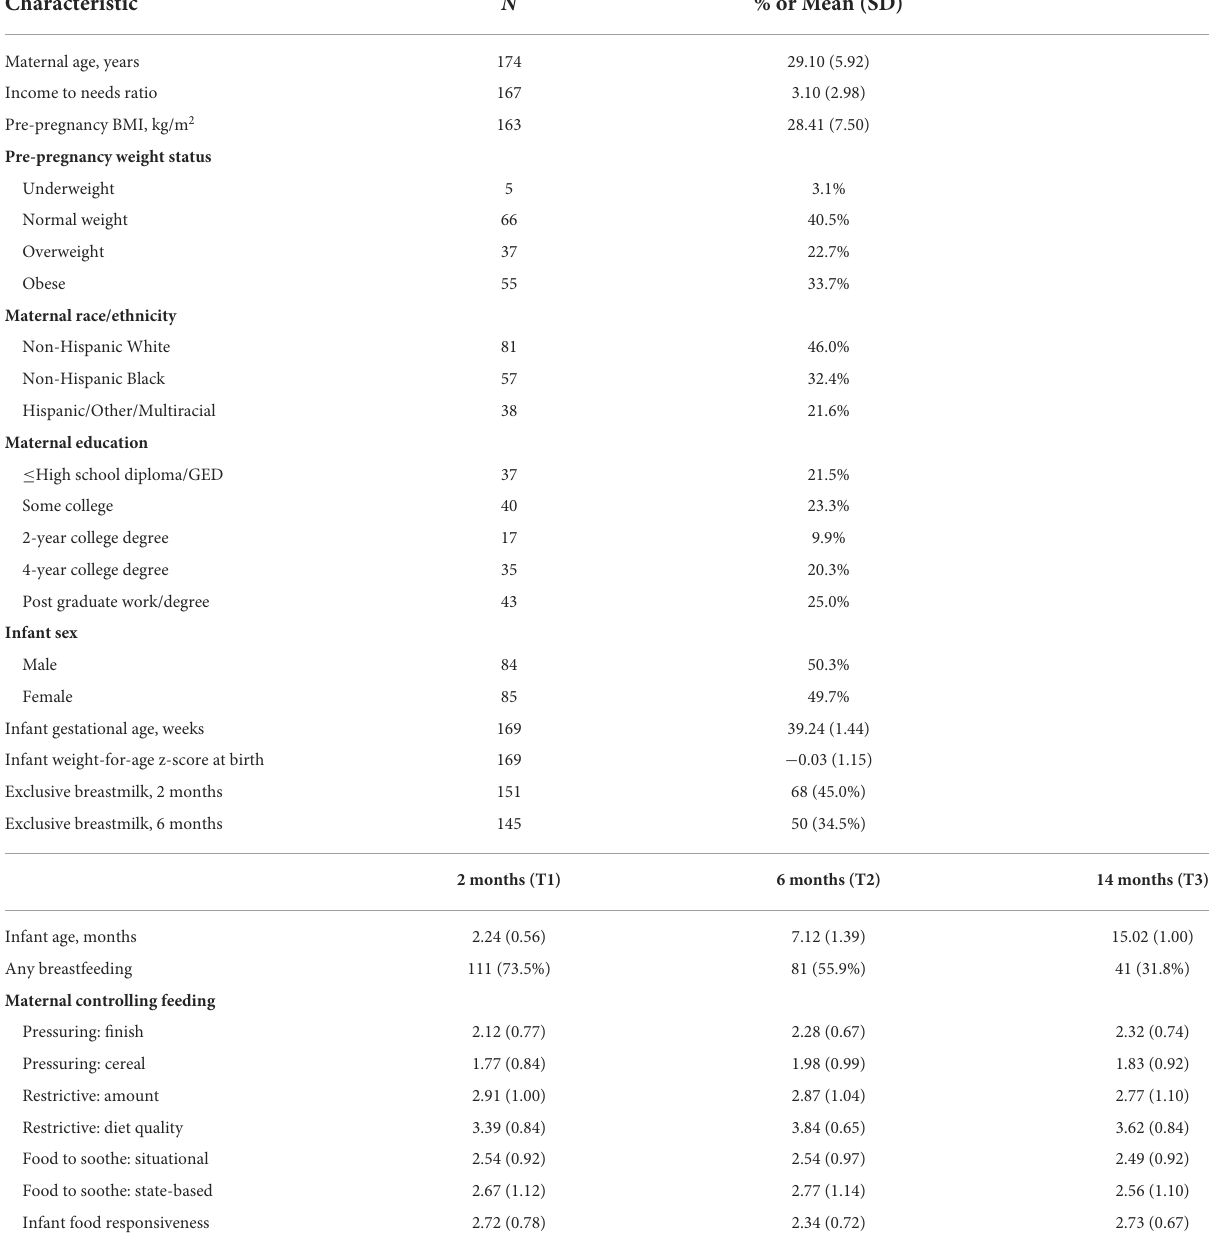
TABLE 1 Sample characteristics and descriptive statistics for primary variables (at baseline unless otherwise noted), N = 176. Characteristic N % or Mean